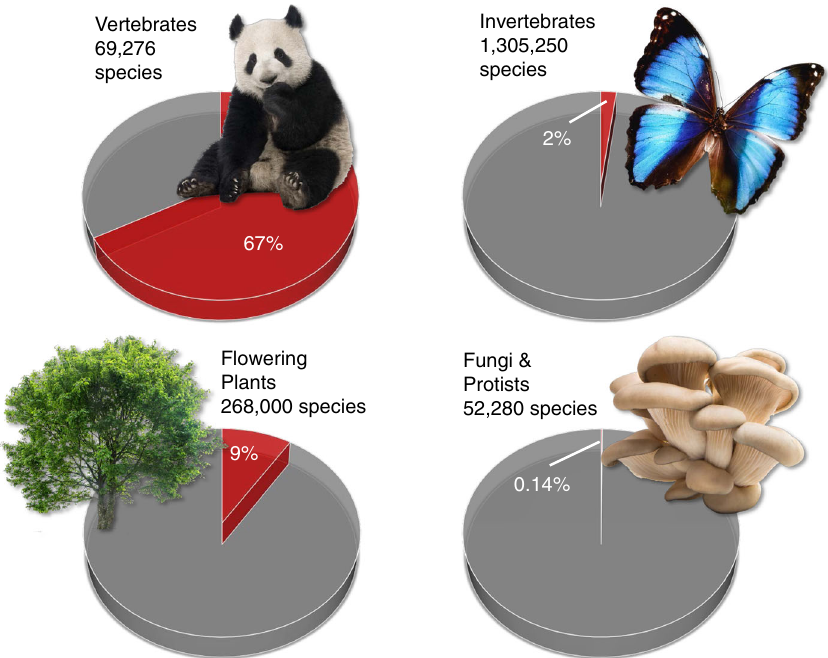
Fig. 1 Underrepresentation of invertebrates on IUCN Red List. Examples for percentages of species assessed on IUCN Red List by 2018 in comparison to the number of described species 7 . Notably, there is high variability in the percentage of evaluated species within these broad categories. For instance, only ~0.8% of all described insect species was evaluated in 2018. Photo credits: panda: Eric Isselée; butter fl y: Fotokon; tree: Production Perig; fungi: ksena32 (all